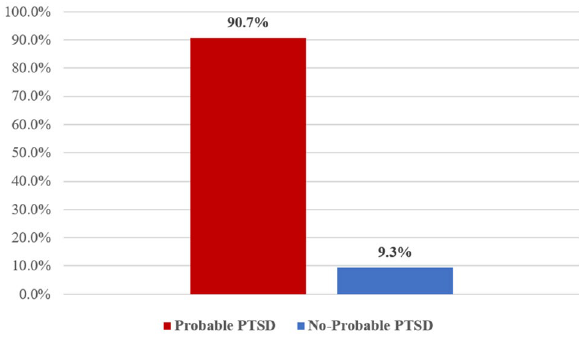
Figure 1. Probable PTSD prevalence in bereaved